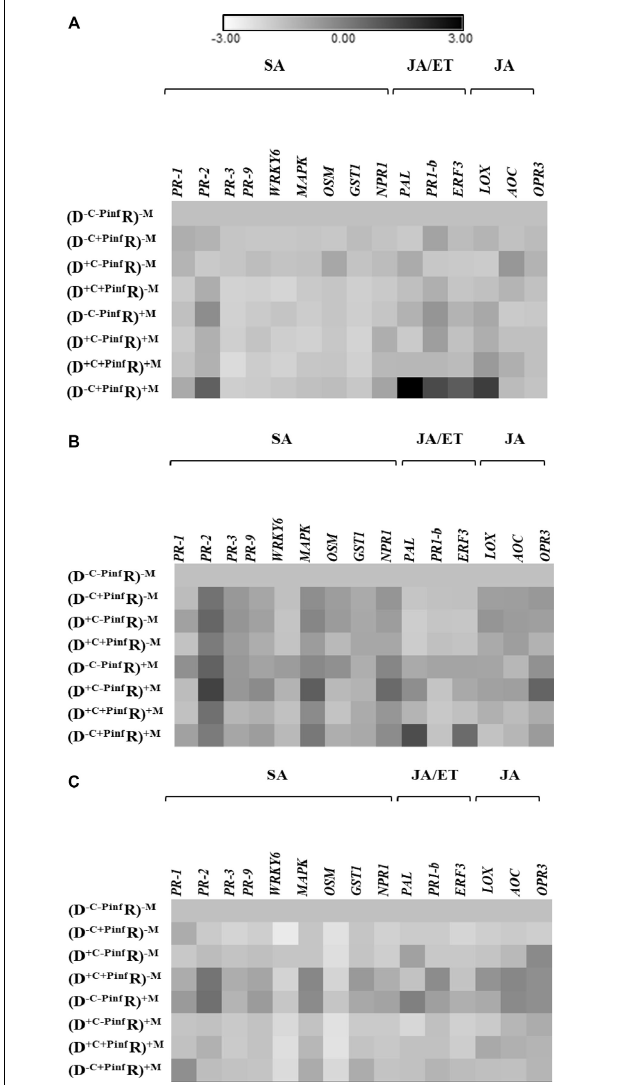
FIGURE 2 | Heat map of the 15 genes relative expression; upregulated and downregulated ratio (in ln) in the leaves of potato receiver plantlets—R (i.e., plantlets grown in the HC), (A) 24 h, (B) 48 h, and (C) 120 h post inoculation of a donor—D plantlet by P. infestans (i.e., plantlets grown in the RC). The different treatments were donor plantlets colonized or not by the AMF (+M, − M), their shoot infected or not by P. infestans (+Pinf, − Pinf), and the medium in the RC cut or not (+C, − C). Fold change of gene expression of the treatment used for the normalization (D − C − Pinf R) − M is equal to 1. Quantitative real-time RT-PCR was used to detect the transcripts of 15 target genes. Seven salicylic acid (SA) dependent genes; pathogenesis related 1 ( PR-1 ), pathogenesis related 2 ( PR-2 ), pathogenesis related 3 ( PR-3 ), pathogenesis related 9 ( PR9 ), WRKY transcription factor 6 gene ( WRKY6 ), mitogen-activated protein kinase ( MAPK ), osmotine like ( OSM ), gluthatione-S-transferase 1 ( GST1 ), putative regulatory protein non-expressor of PR genes 1 ( NPR1 ). Two jasmonic acid (JA) and ethylen (ET) dependent genes; phenylalanine ammonia lyase ( PAL ), pathogenesis related 1 basic ( PR-1b ). One ET dependent gene: ethylene response factor 3 ( ERF3 ). Three JA dependent genes: lipoxygenase ( LOX ), allene oxide cyclase ( AOC ), OPDA reductase 3 ( OPR3 ). Every square are means of eight replicates at 24 h and 48 hpi and four replicates at 120 hpi ( Supplementary Table S1 Expression fold